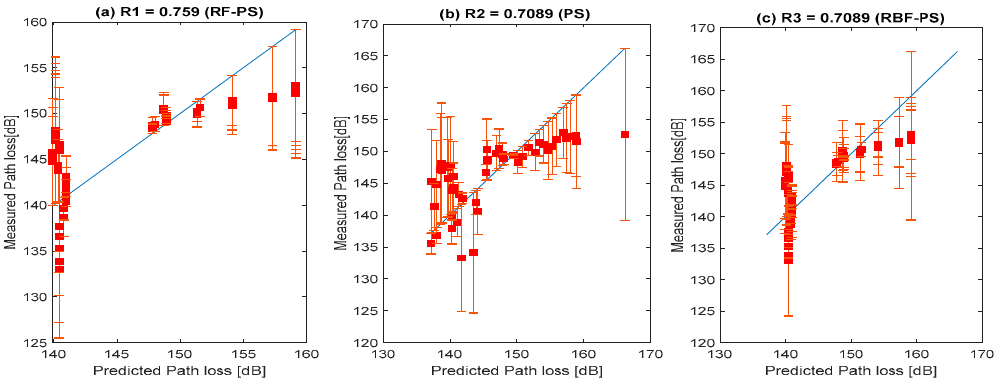
Figure 31. Results showing the correlation between the measured path loss and predicted path loss using the hybrid RF-PS prediction method and two existing standard path loss prediction methods in site 3 of location 4. Table 2. Computed MAE values attained with developed path loss model and other key existing standard prediction approaches.